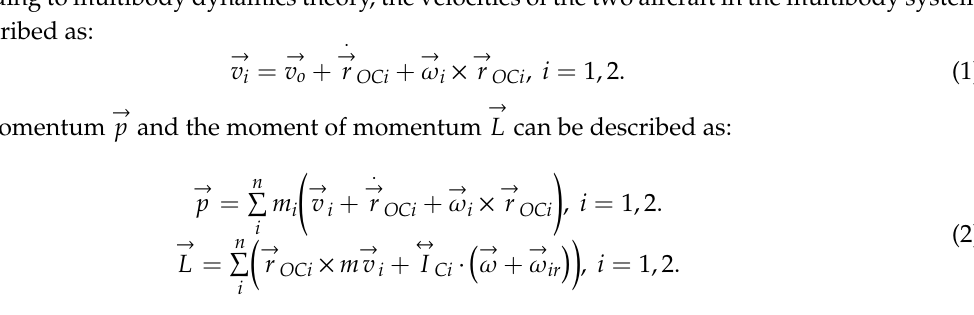
Figure 4. Wingtip-jointed aircraft system body co-ordinates.